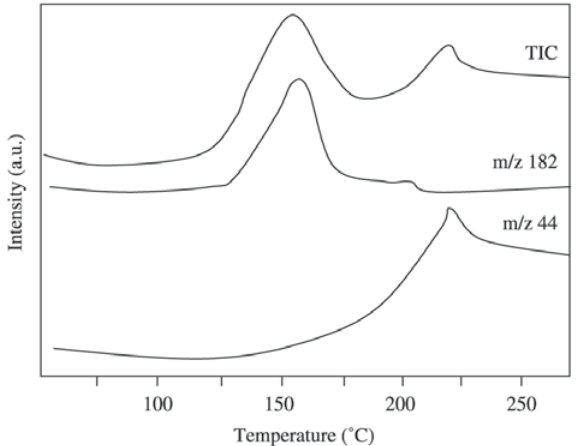
Figure 10. TG analyses of the (a) HNO functionalyzed carbons in